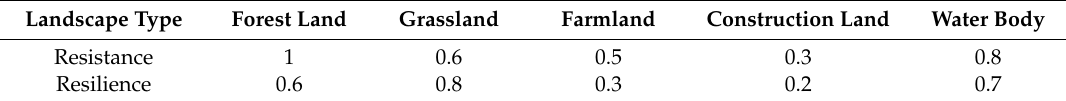
Table 2. The ecosystem resistance coe ffi cient and resilience coe ffi cient of each landscape type. Landscape Type Forest Land Grassland Farmland Construction Land Water Body Resistance 1 0.6 0.5 0.3 0.8 Resilience 0.6 0.8 0.3 0.2